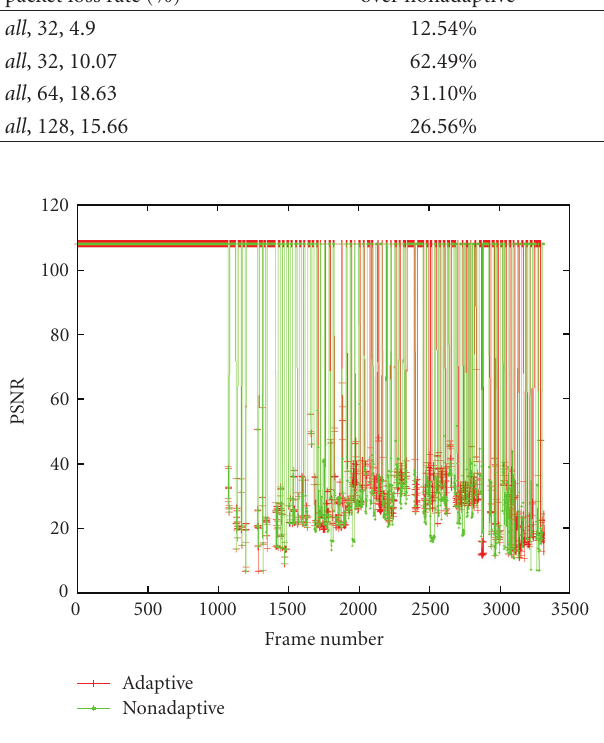
Figure 15: PSNR comparisons for “ all ” sequence at 128kbps, random delay 0.012, bu ff er size 500, packet size 256, span 8, PL rate 15.66%.